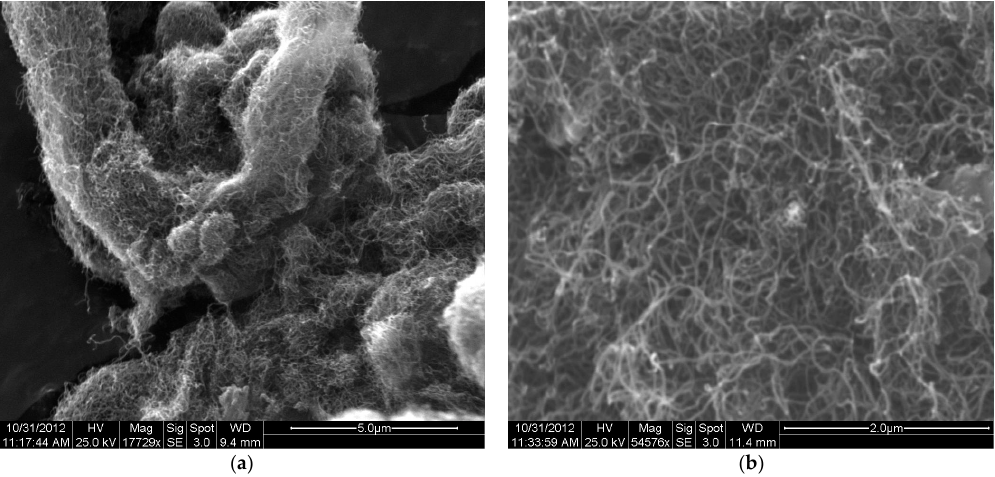
Figure 3. Surface topology by SEM images of the functional CNT samples pre- and post-conjugation with sodium alginate: ( a ) as-received CNTs; ( b ) functional CNTs = 100%.